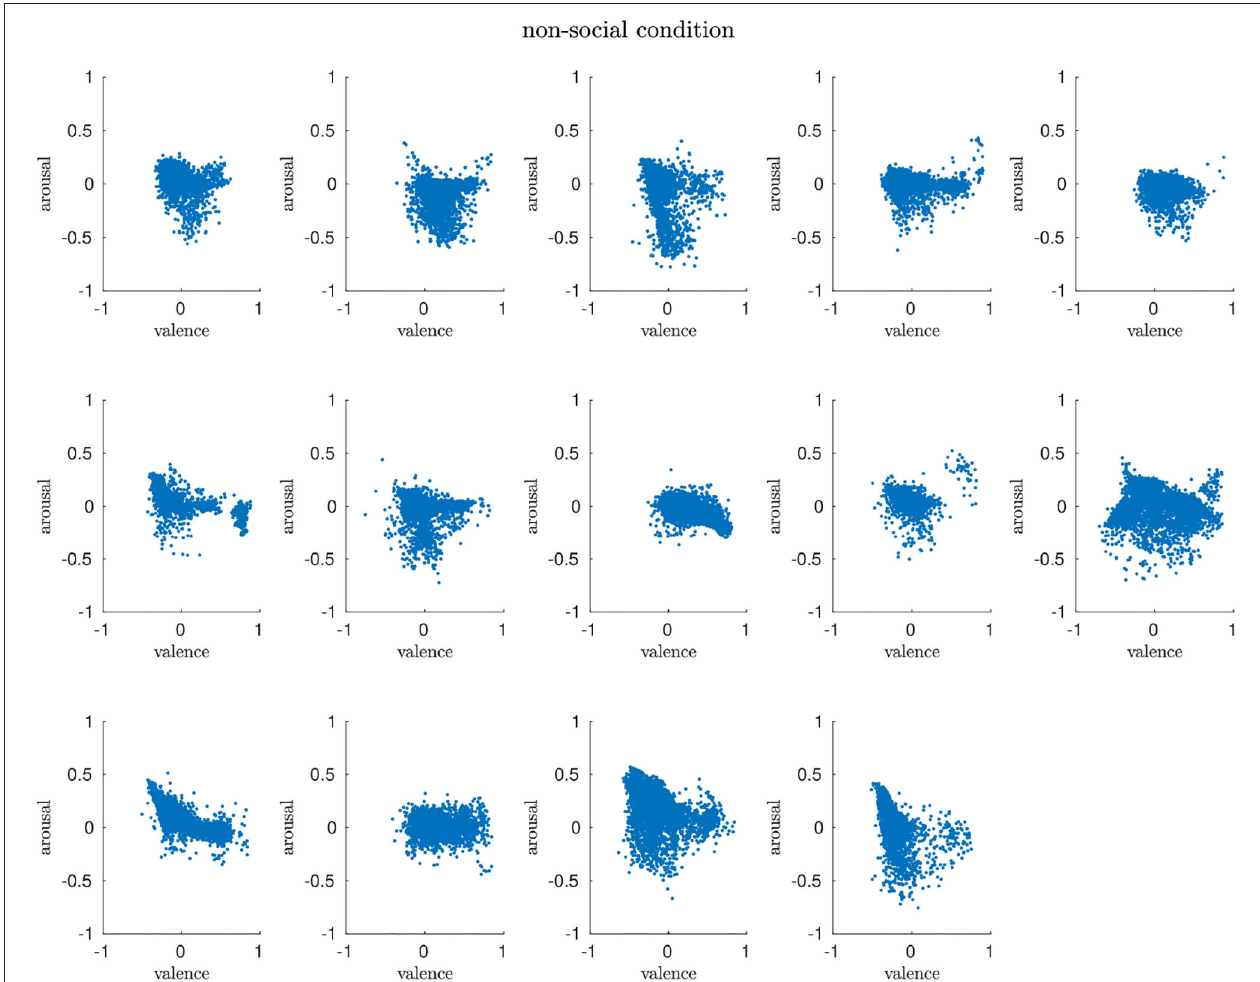
FIGURE 4 | The arousal and valence patterns in the non-social condition are very diverse, covering a huge space of the arousal-valence